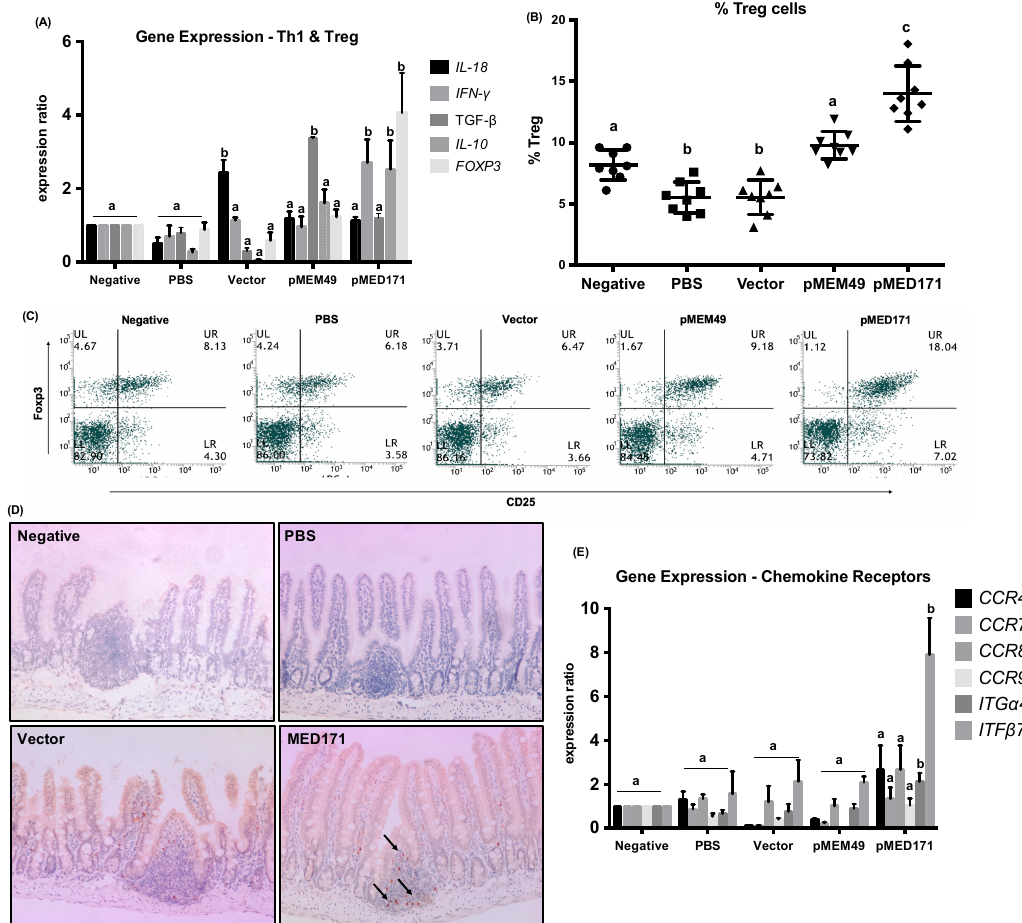
Figure 2. Th1, Treg, and chemokine responses with pMEM49 and pMED171 treatment. ( A ) Local expression of Th1 and Treg cytokines and transcription factors in the small intestine detected by qPCR. ( B ) Frequency of splenic Treg cells gated as CD4 hi and CD25 + Foxp3 + cells. Individual data points denoted by different symbols for each experimental group are shown. ( C ) Representative flow plot showing the frequency of splenic Treg cells in control and treatment groups. ( D ) Representative photomicrographs of Foxp3 + T cells in the ileum (arrows indicate Foxp3 + T cells stained brown in IHC; magnification = 200×). ( E ) Local expression of chemokine receptors and gut-homing signals in the small intestine detected by qPCR. Note the significant enhancement of Treg activities with pMEM49 and pMED171 treatment, despite the differential magnitude and type of Treg responses. Data are shown as mean ± SD. Statistical differences among different experimental groups were determined by Bonferroni post-test after one-way ANOVA; groups denoted by the same alphabet are not significantly different, while those denoted by different alphabets are statistically different ( p < 0.05).